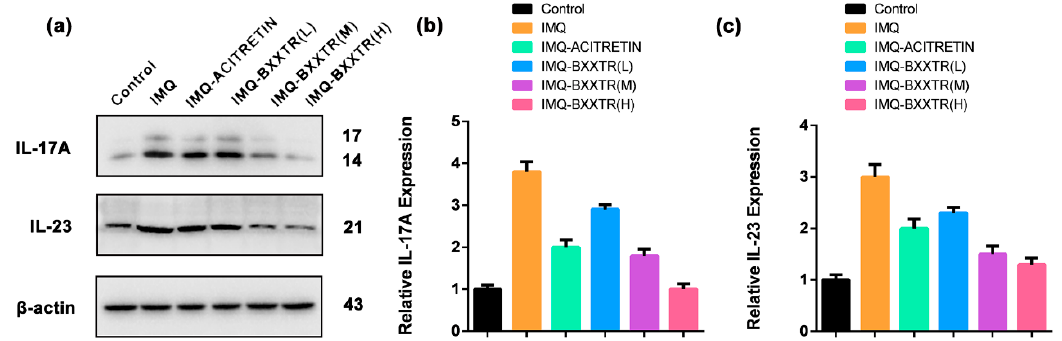
Figure 6. BXXTR could decrease of IL-17A and IL-23 levels in the back skin of BALB/c mice. ( a – c ) The expression of IL-17A and IL-23 in the back skin of BALB/c mice of different groups were measured with western blot.